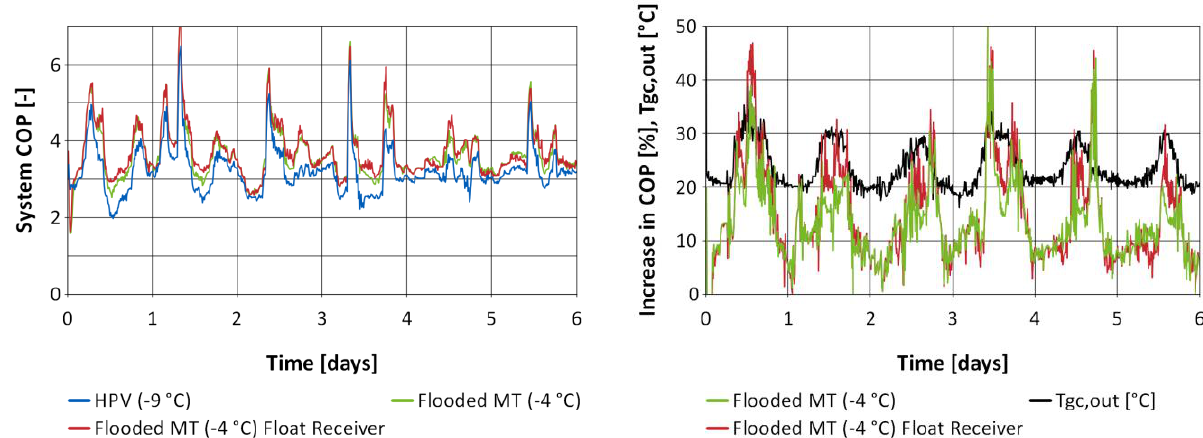
Figure 13. Analysis of the effect of MT flooded evaporation on system performance, both with fixed and floating receiver setpoints. ( Left ), system COP for HPV system compared to ejector-supported flooded evaporation. ( Right ), increase in COP during the reference week on the basis of the HPV system layout.